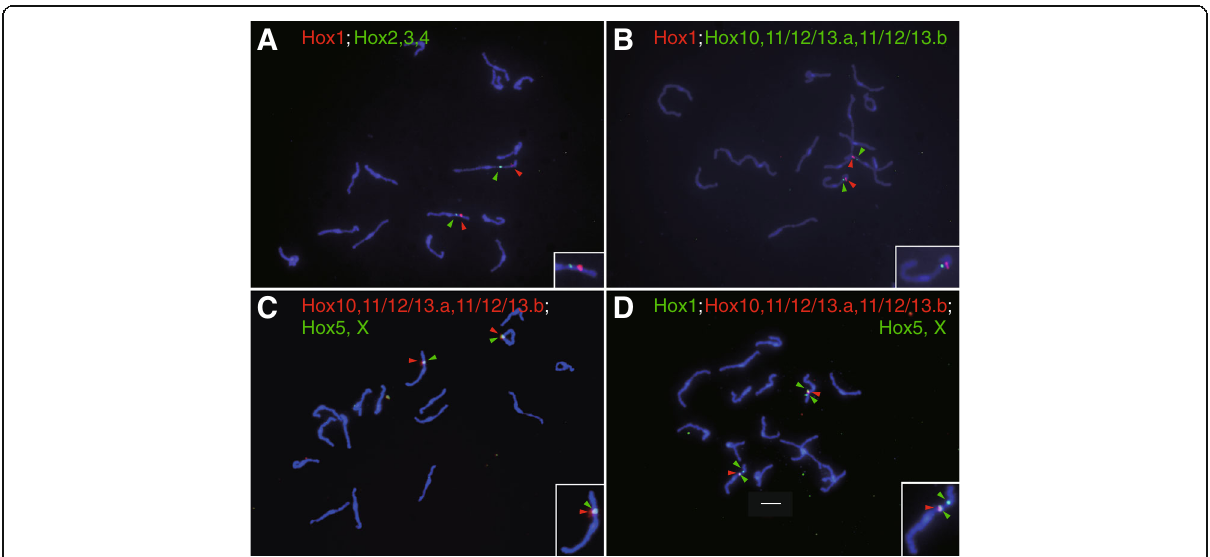
Fig. 3 Mapping of Halocynthia roretzi Hox genes onto metaphase chromosomes ( a - d ). Metaphase chromosome spreads were prepared from cleavage stage Hr embryos and hybridized with two or three probes labeled with digoxigenin (red) or biotin (green) for genes indicated at the top of each panel. Chromosomes were stained with DAPI. Red and green arrowheads indicate signals for the gene of the same color code. In the right bottom corner of each panel, enlargement of one of the chromosomes with signals is shown in inset. Within a chromosome, a pale blue stained region corresponds to the centromeric region. The bar in d indicates 5 μ m and is applicable to all panels. BAC clones used for probes were 5 J1 (Hox1), 3C14 (Hox2, Hox3 and Hox4), 6B23 (Hox5 and HoxX) and 1 J20 (Hox10, Hox11/12/13.a and Hox11/12/13.b)